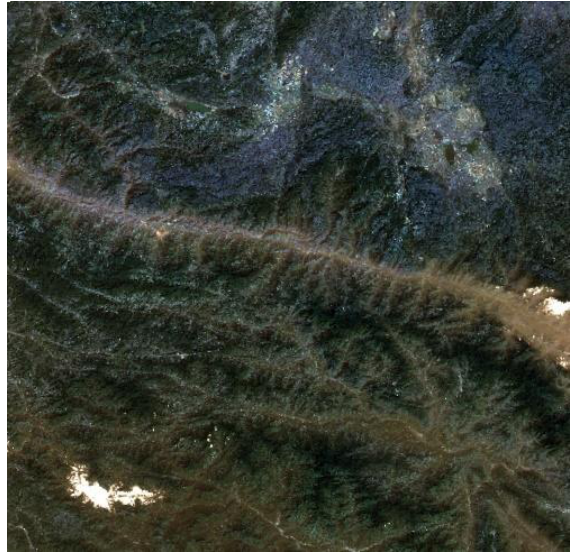
Figure 3. The 321 band RGB synthesis.